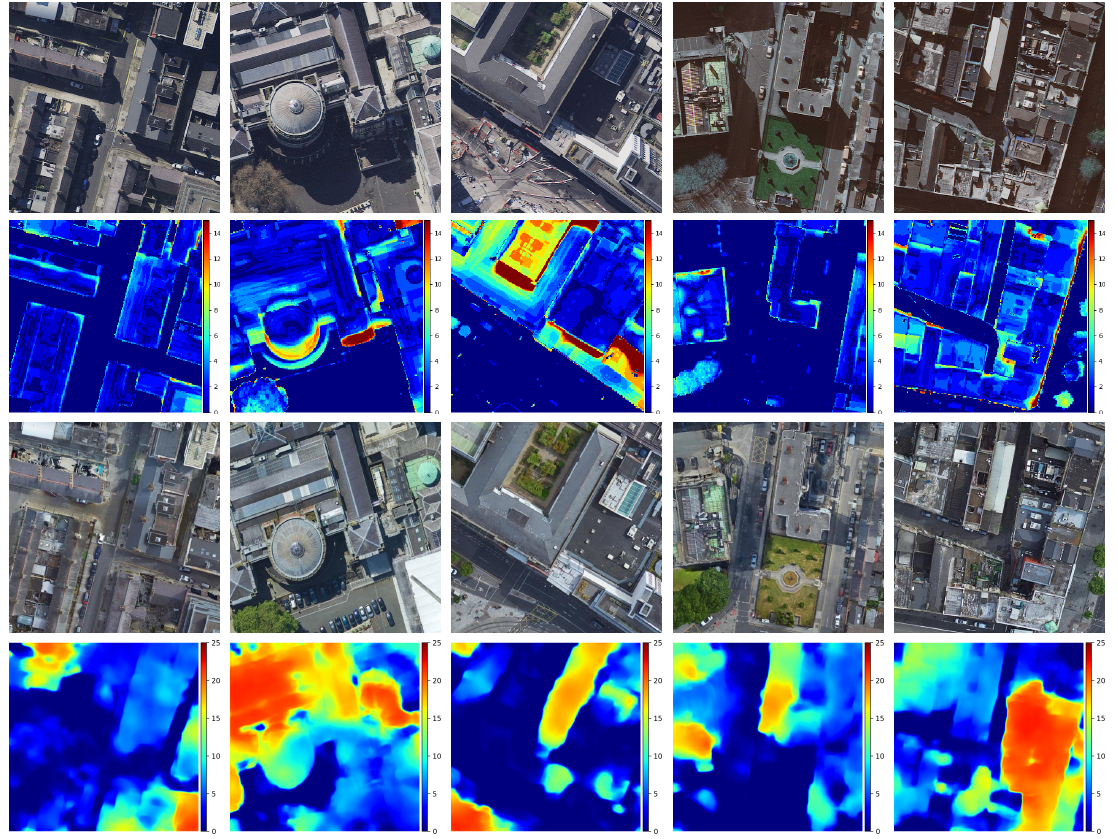
Figure 13. Comparison of DSM reconstruction (without retraining) from OSI aerial imagery (row 1) and Google Maps satellite images (row 3) and the corresponding error of estimations heat